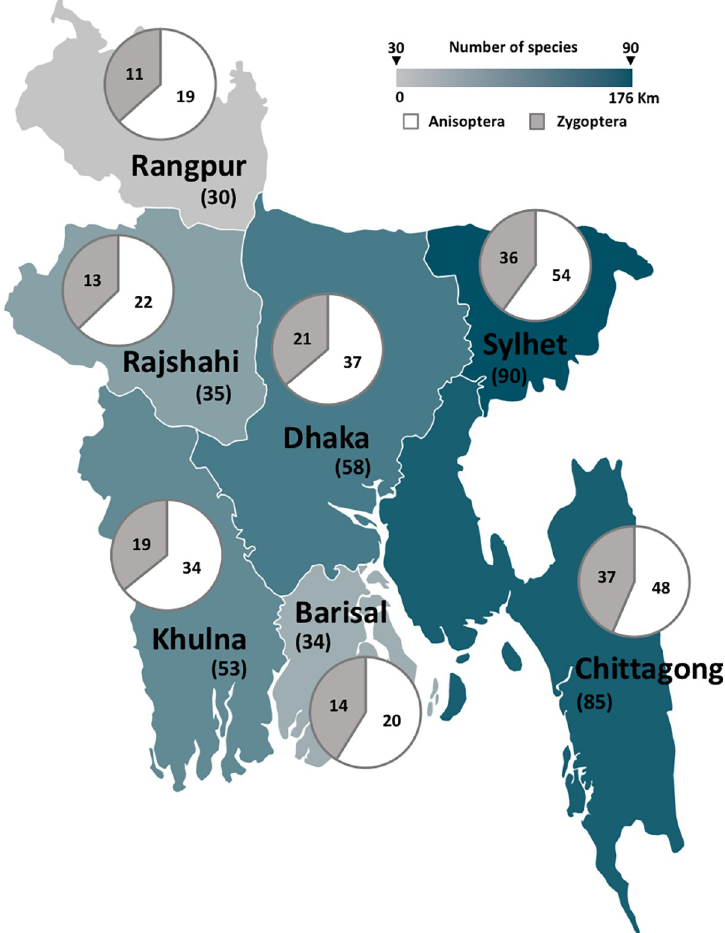
Fig 2. A reference map of different divisions of Bangladesh with the number of extant Odonata species in that region. Sub-order Anisoptera is represented in white and Zygoptera is represented in